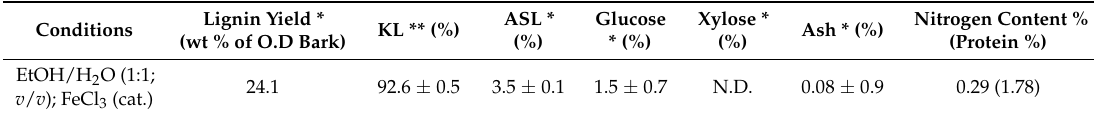
Table 3. Chemical properties of sugar maple bark lignin obtained by organosolv pulping of pre extracted bark.